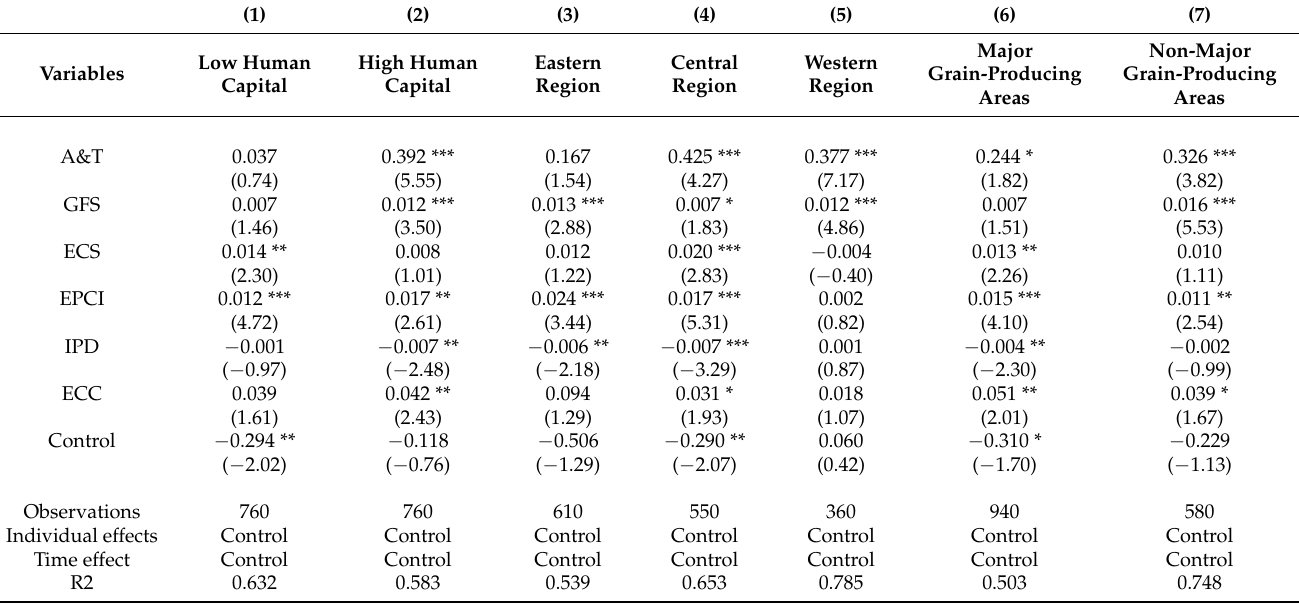
Table 4. Heterogeneity